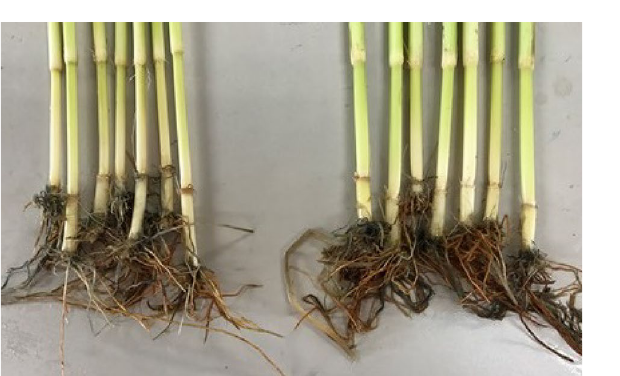
Figure 3. Comparison of strong-culm traits related to lodging resistance for each QTL combination. ( a – c ) Comparison of bending-type lodging resistance-related traits. ( a ) Secondary moment of inertia. ( b ) Young’s modulus. ( c ) Bending rigidity. ( d – f ) Comparison of breaking-type lodging resistance-related traits. ( d ) Section modulus. ( e ) Bending stress. ( f ) Bending moment at breaking. Each column shows mean ± SD of three replicates. *, ** and *** indicate significant differences compared to Koshihikari at the 5%, 1% and 0.1% level (Dunnett’s test). The numbers in parentheses show the values relative to Koshihikari (100).